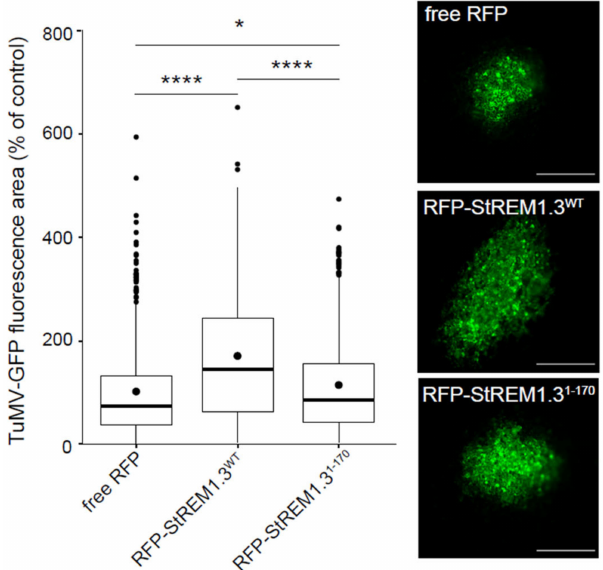
Figure 4. REM–CA-mediated PM binding is required for StREM1.3 increasing TuMV cell-to-cell propagation. Effect of transient overexpression of RFP-StREM1.3 1–170 . The area of infection foci is normalised and expressed in % of the area of virus propagation in the absence of REM (RFP negative control). At least 350 infection foci from at least 4 independent experiments were imaged at 5 days post-inoculation (dpi). Statistical analysis was performed using one-way ANOVA,